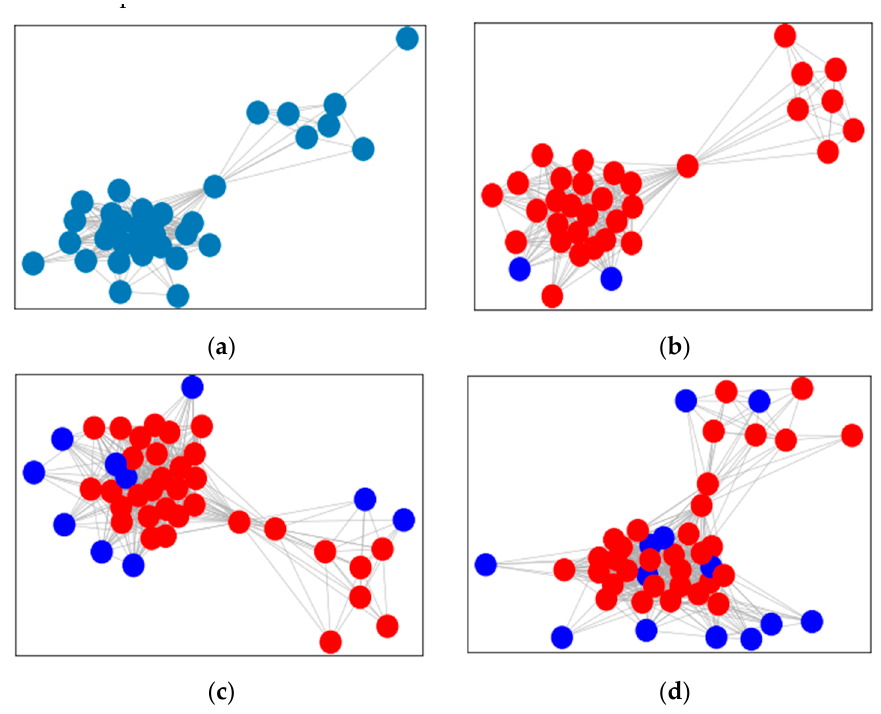
Figure 8. Change of group structure with time. ( a ) February; ( b ) March; ( c ) April; ( d ) May.